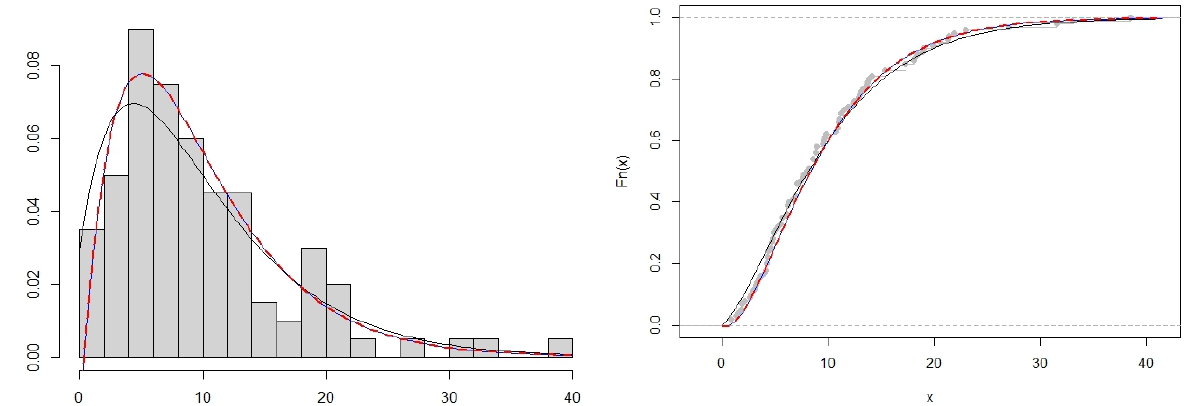
Figure 3. Fitted Lindley (black), 3PL (blue), and ncL (red) models with corresponding estimated distribution functions for the banking waiting times dataset.